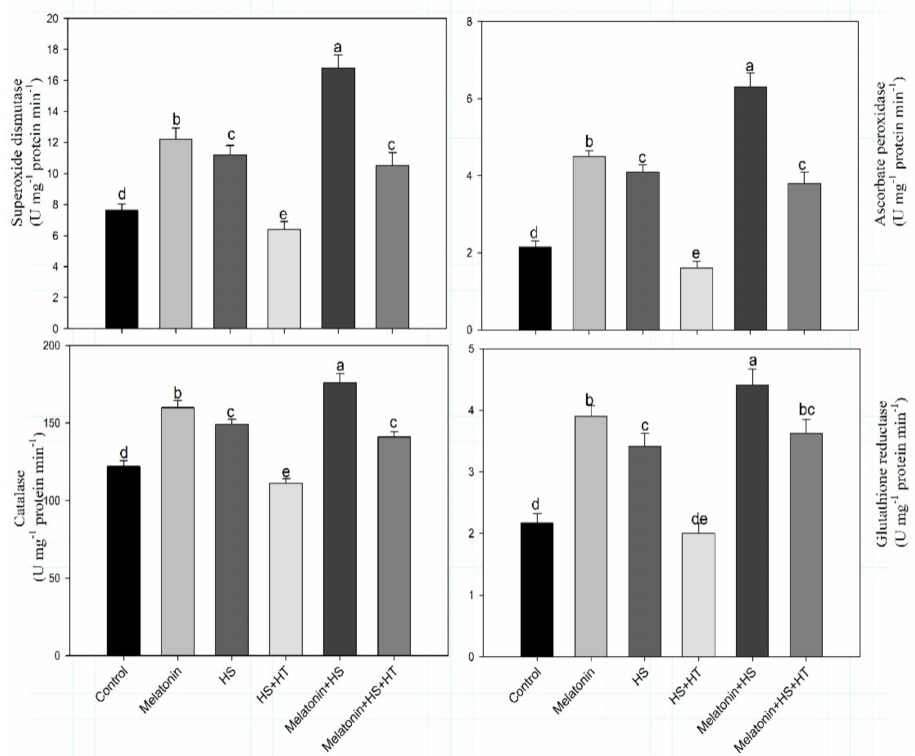
Figure 5. Activity of superoxide dismutase, ascorbate peroxidase, catalase and glutathione reductase of wheat ( Triticum aestivum L. var. WH 542) leaves at 30 days after sowing (DAS). Plants were treated with melatonin (100 µ M) and/or HT (100 µ M) in the presence (40 ◦ C) or absence (25 ◦ C) of heat stress. Data are presented as means ± SE ( n = 4). Data followed by the same letter are not significantly different by LSD test at p < 0.05. APX, ascorbate peroxidase; CAT, catalase; GR, glutathione reductase; HS, heat stress; HT; hypotaurine; SOD, superoxide